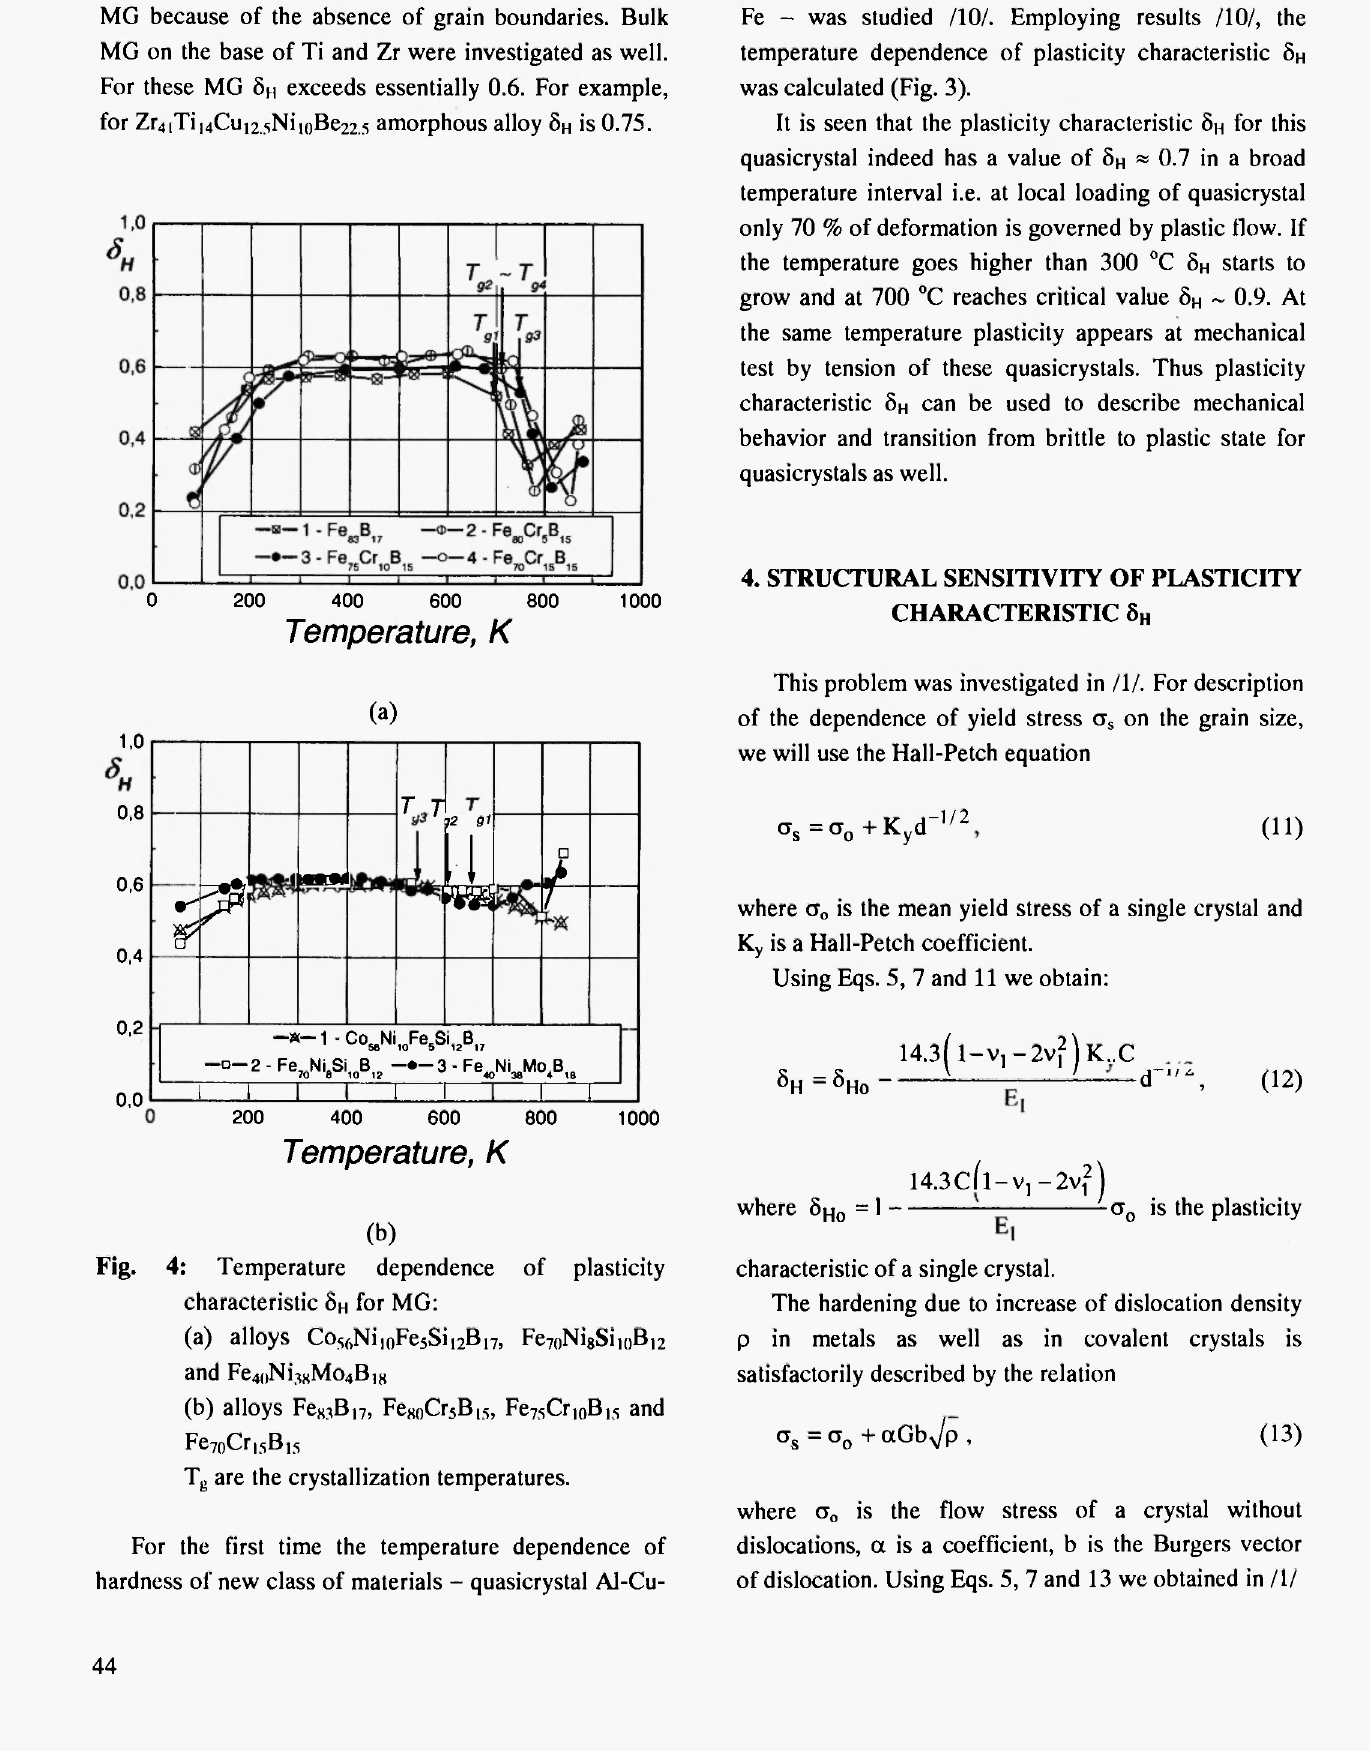
4: Temperature dependence of